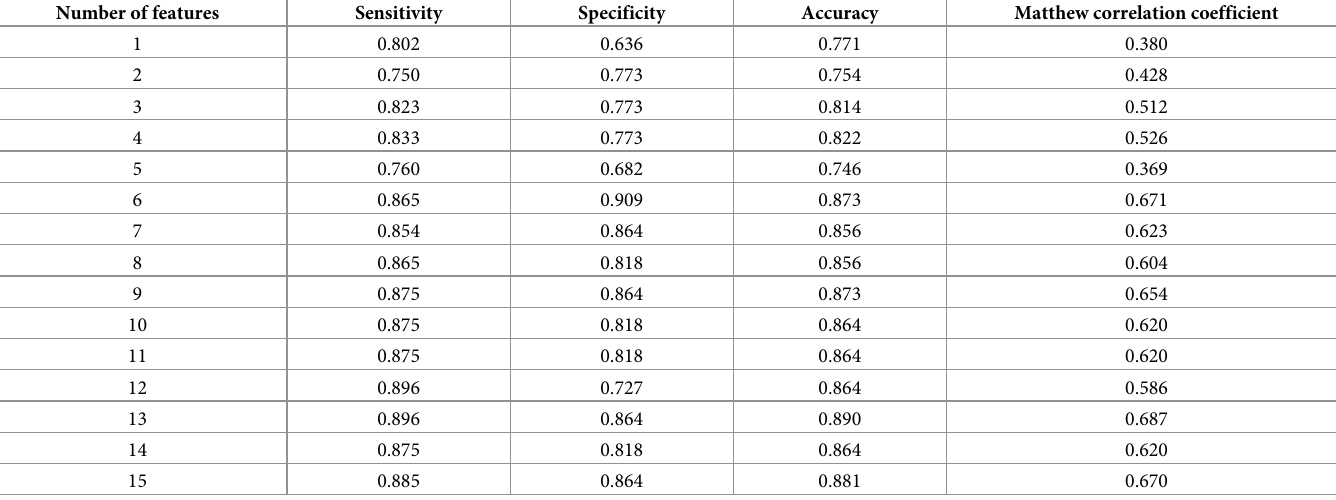
Table 3. IFS performance with RIPPER and different top